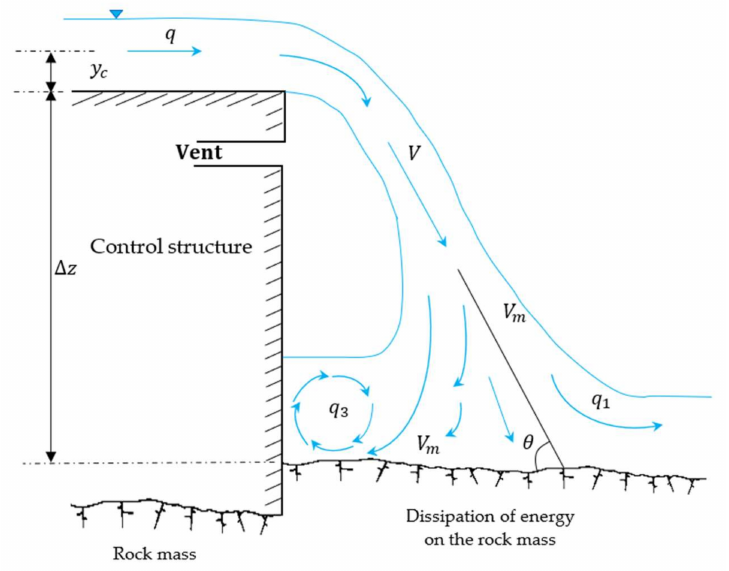
Figure 8. Schematic representation of a plunging flow according to Annandale